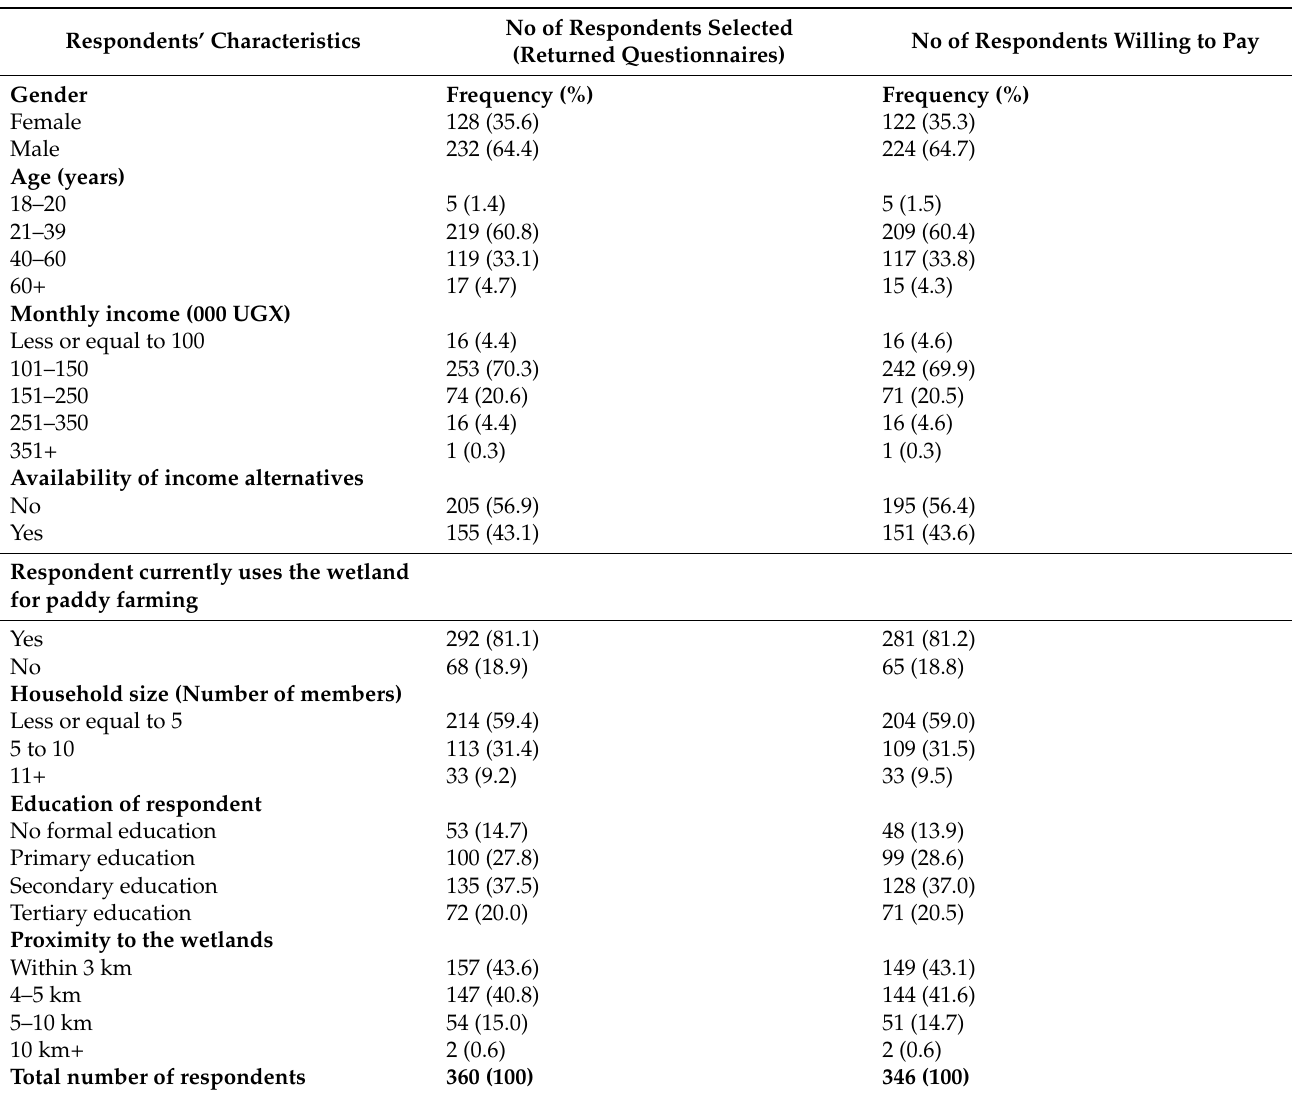
Table 2. Descriptive statistics of the respondents with and without protest